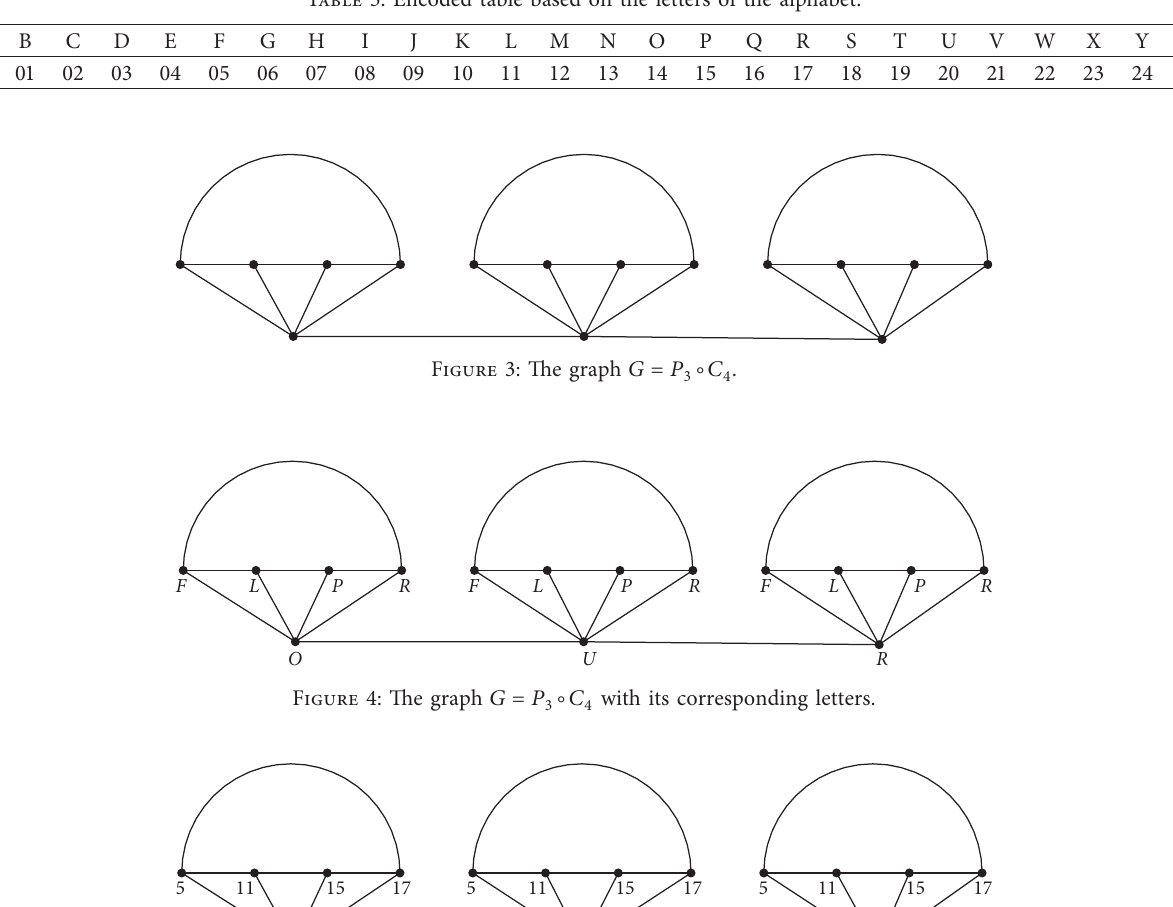
Figure 5: A graph G � P